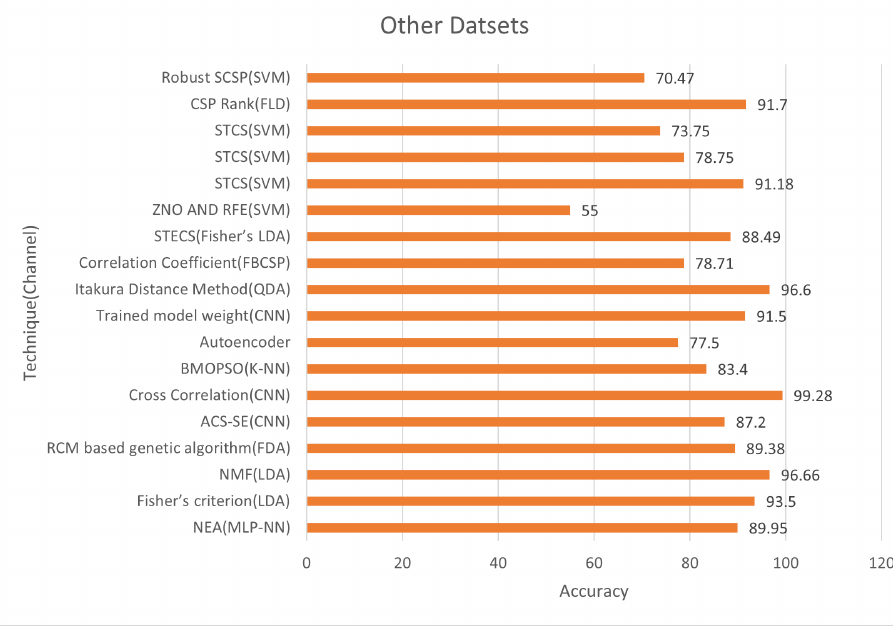
Figure 13. Accuracy by different techniques for different